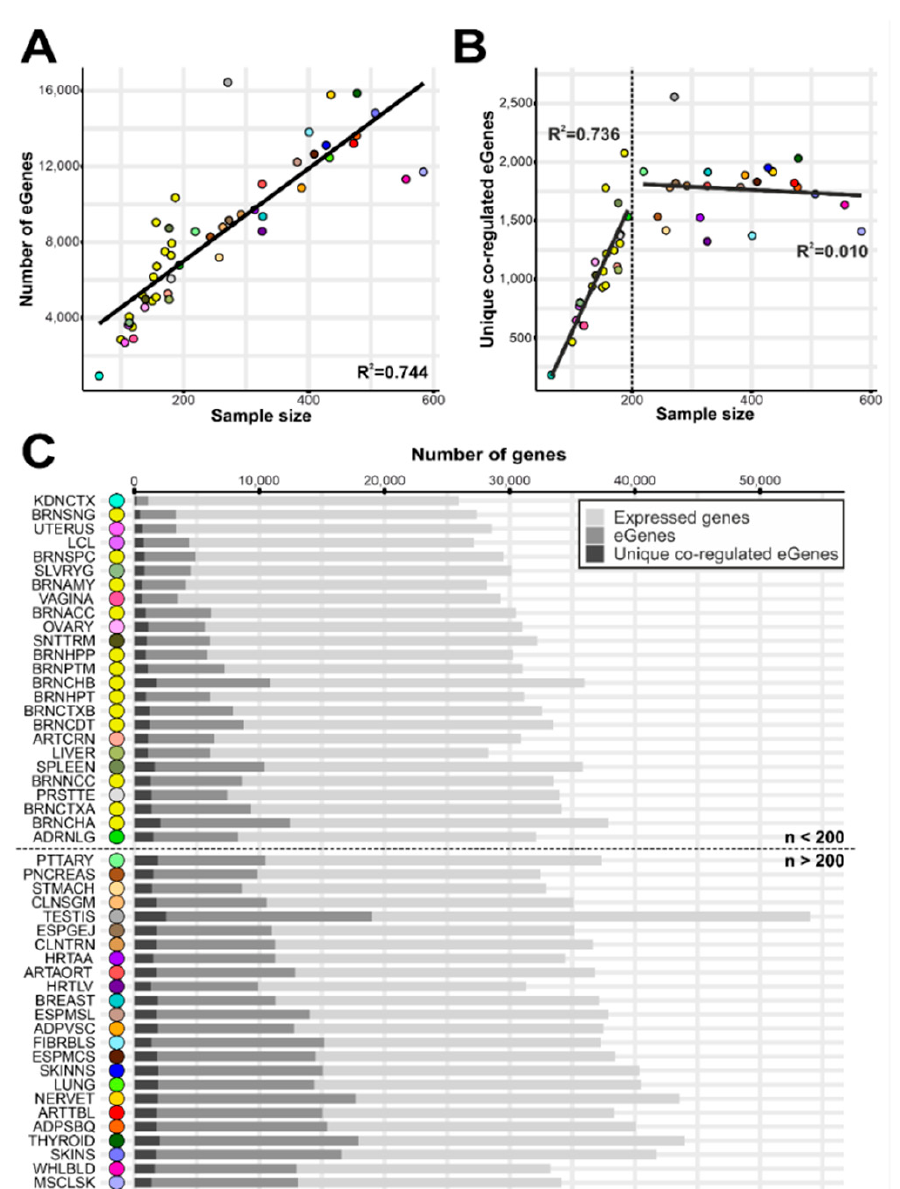
Figure 2. Gene-centered analysis of co-regulated genes. eQTL were calculated in 49 tissues from GTEx project data based on gene expression and genotype data of 694 samples from donors of European descent. The sample sizes varied widely between the tissues, namely from 65 (KDNCTX) to 584 (MSCLSK) (Table S1). ( A ) Number of significant eGenes as a function of sample size. The regression coefficient (R 2 ) of the linear model is 0.744 ( p -value = 1.6 × 10 − 15 ) ( B ) Number of significant eGenes, co-regulated with at least one other eGene, as a function of sample size of the respective tissue. A significant correlation was observed for tissues with less than 200 samples ( p -value = 4.2 × 10 − 8 , R 2 = 0.736), whereas the linear regression model was not significant considering tissues with samples sizes above 200 ( p -value = 0.6, R 2 = 0.010). Consequently, the number of eGenes over 200 samples per tissue with at least one co-regulation partner is not correlated with sample size. ( C ) Visualization of the number of expressed genes (light grey), the number of eGenes (medium grey), and the number of eGenes, which are co-regulated with at least one other eGene (dark grey) in the 49 tissues analyzed. The tissues are ordered from top to bottom by sample size in decreasing order. The black dotted line separates tissues with 200 or less samples (above) from those with sample sizes over 200 per tissue (below). The color code was retrieved from the GTEx project [18]. A detailed list of tissues analyzed and their respective abbreviation is given in Table